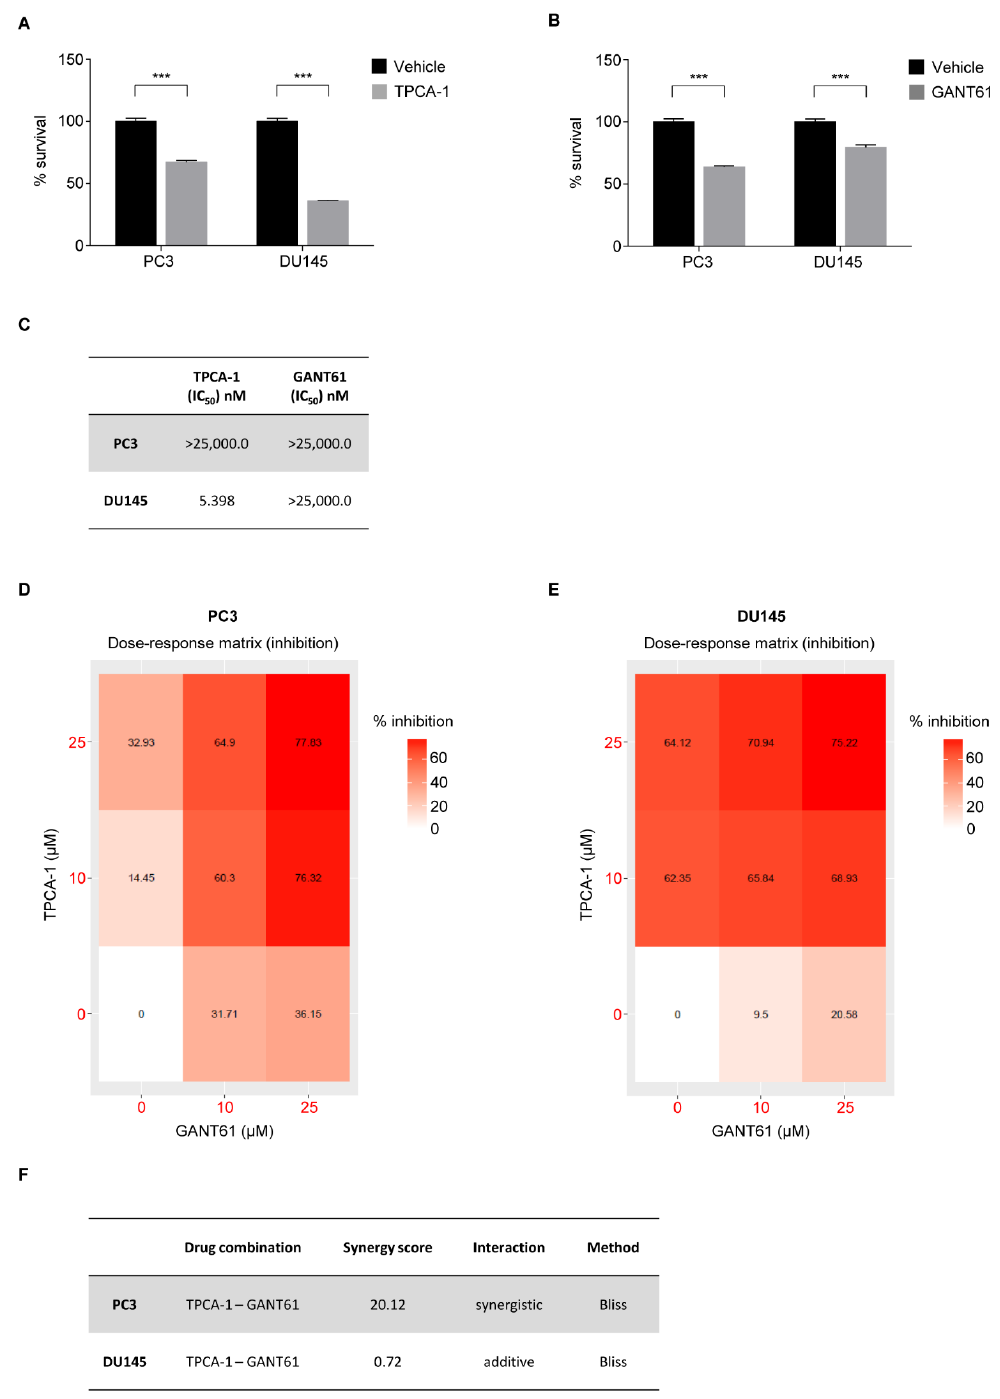
Figure 5. Inhibition of NF- κ B and GLI1 kills AI cell lines. ( A , B ) CellTiter-Glo assays showing the viability of PC3 and DU145 cell lines following 72 h of treatment with TPCA-1 ( A ) and GANT61 ( B ) or vehicle. ( C ) Shown are IC 50 values of TPCA-1 and GANT61 at 72 h for the experiment reported in ( A , B ). ( D , E ) Heatmap showing the dose–response matrix (% inhibition) for TPCA-1 and GANT61 of PC3 ( D ) and DU145 ( E ) cell lines after 72 h of treatment. ( F ) Shown is the synergy score of TPCA-1 and GANT61 for the experiments shown in ( D , E ). ( A , B ) Values are shown as mean ± S.D. Unpaired Student t -test or Mann–Whitney U-test were used for statistical analysis. *** p < 0.001. All experiments were performed in triplicate. ( C , F ) PC3 (grey) DU145